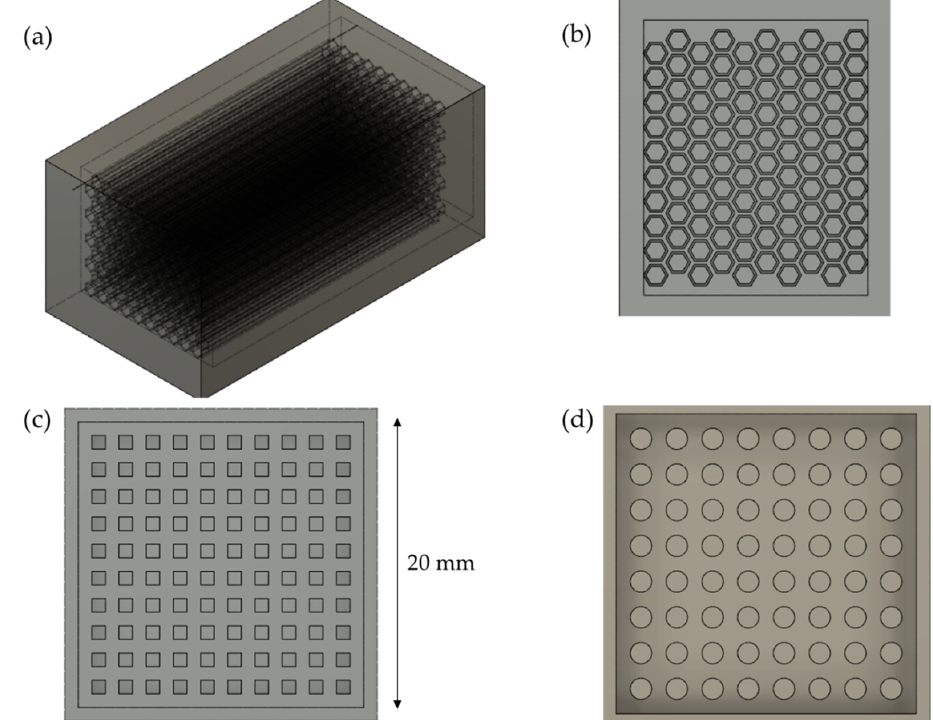
Figure 1. Stick design. ( a ) Stick design: 3D view. The object is 20 mm × 20 mm × 10 mm. The holes’ diameter is 2 mm. The plates are 0.25mm-thick and are separated by 0.25 mm. ( b ) Stick design 1: top view. Inside circumradius: 400 μ m, outside circumradius: 500 μ m. Distance between two adjacent hexagons: 80 µ m. ( c ) Stick design 2: top view. Side: 500 µ m, distance between two adjacent squares: 500 μ m. ( d ) Stick design 3: top view. Diameter: 750 μ m, distance between two adjacent circles: 500 μ m.